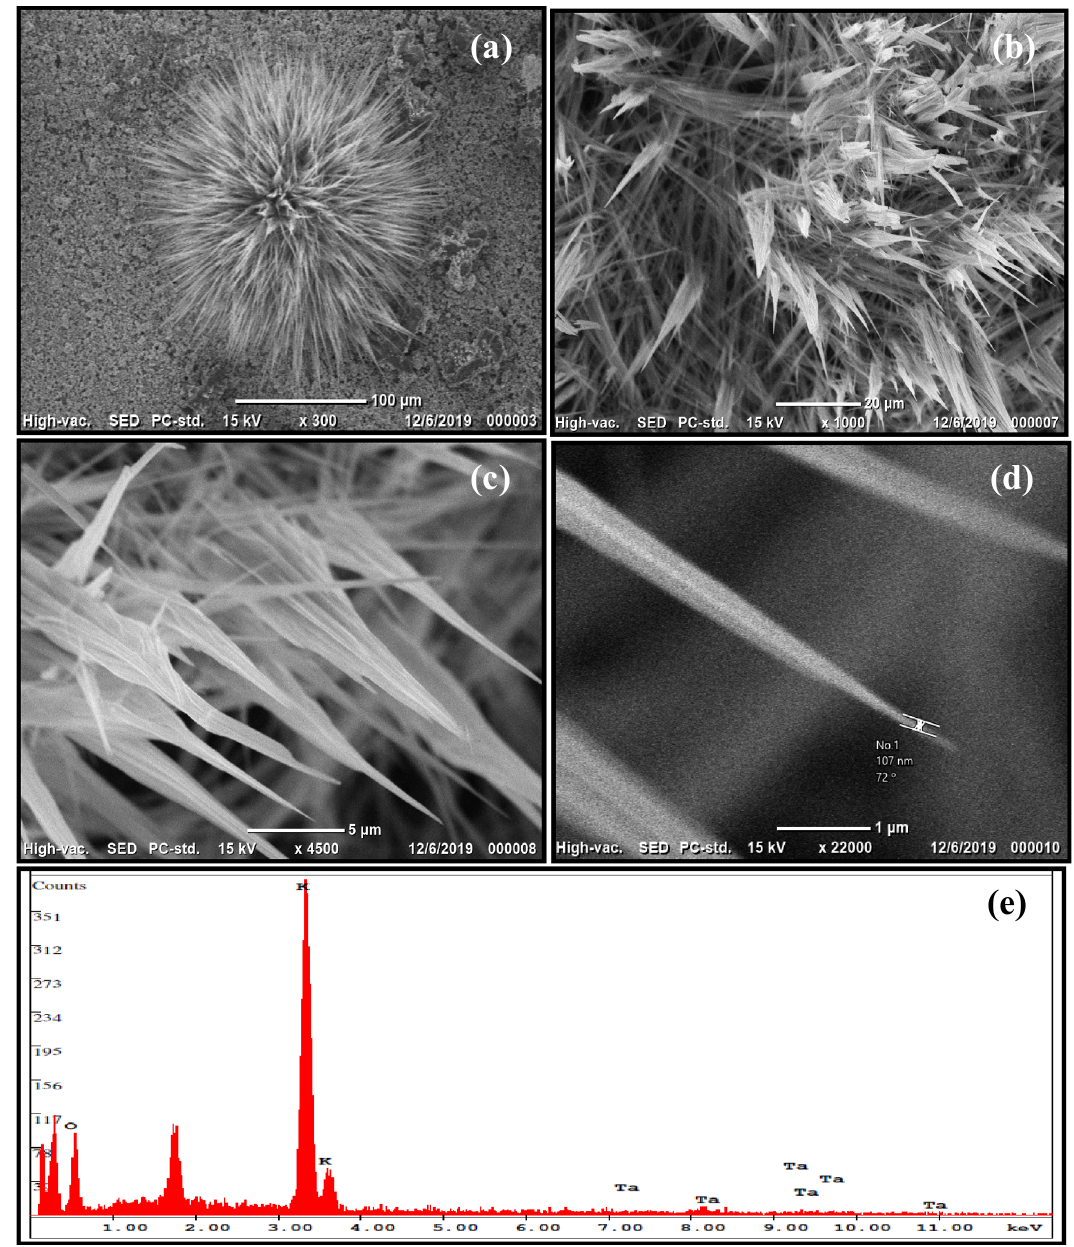
Figure 3. ( a ) 3D flowerlike structure observed at 100 µm range. ( b , c ) Bunch of flower petals showing sharp edges. ( c ) A needle embedded within single petal recorded at 1 µm range of (0.4 g concentration of areca seed powder